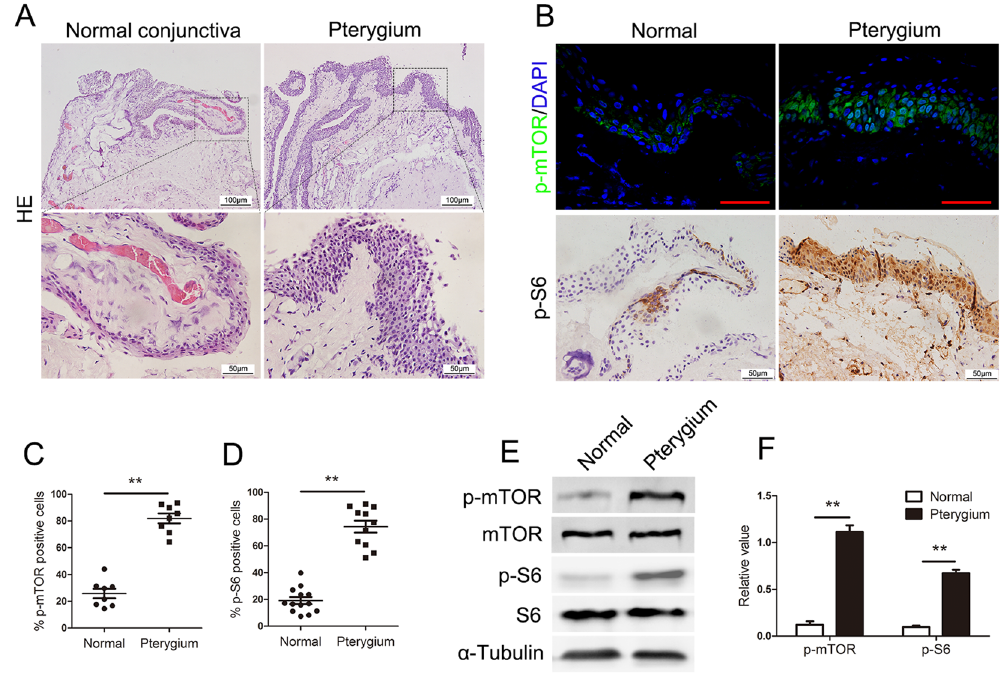
Figure 1. mTORC1 is activated in pterygium epithelial cells. ( A ) H&E staining in pterygium and normal conjunctiva, Scale bar: 50 μ m. Higher magnification is shown on the bottom, Scale bar: 100 μ m. ( B ) p-mTOR (Ser2448) IF staining (b-top) and p-S6 (S235/236) IHC staining (b-bottom) in pterygium and normal conjunctiva, Scale bar: 50 μ m. p-mTOR positive cells ( C ) and p-S6 positive cells ( D ) were significantly increased in pterygium compared with normal conjunctiva. mTOR and mTORC1 activation were confirmed by western blotting (e and f). ** p <